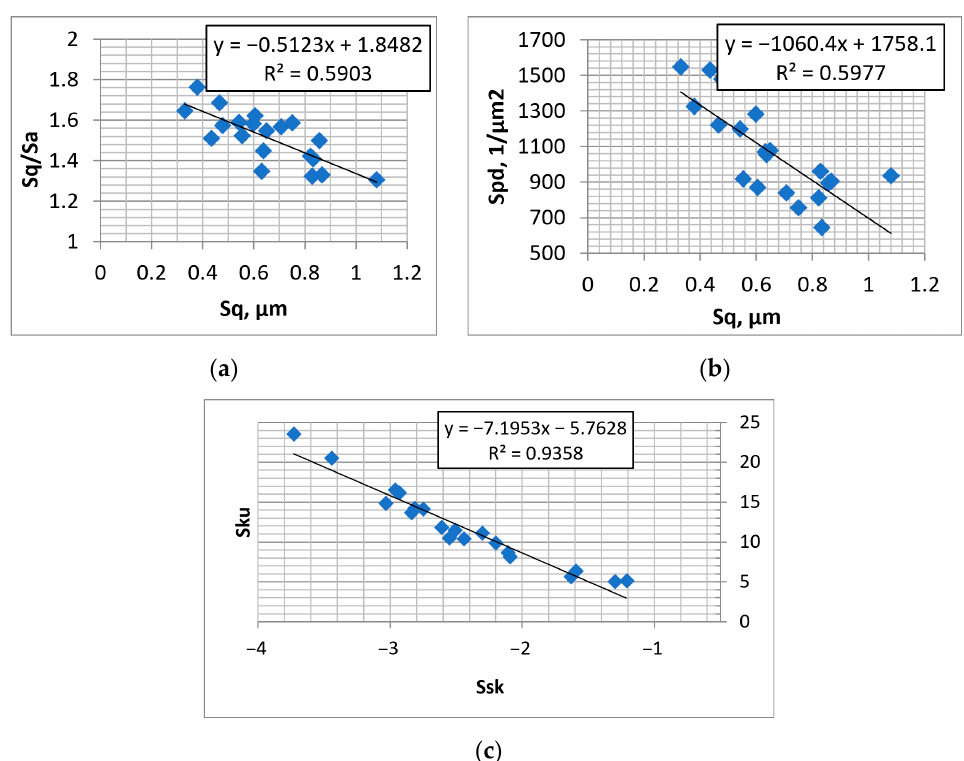
Figure 6. Dependencies between parameters: Sq-Sq/Sa ( a ), Sq-Spd ( b ), and Ssk-Sku ( c ) of plateau-honed cylinder surfaces.